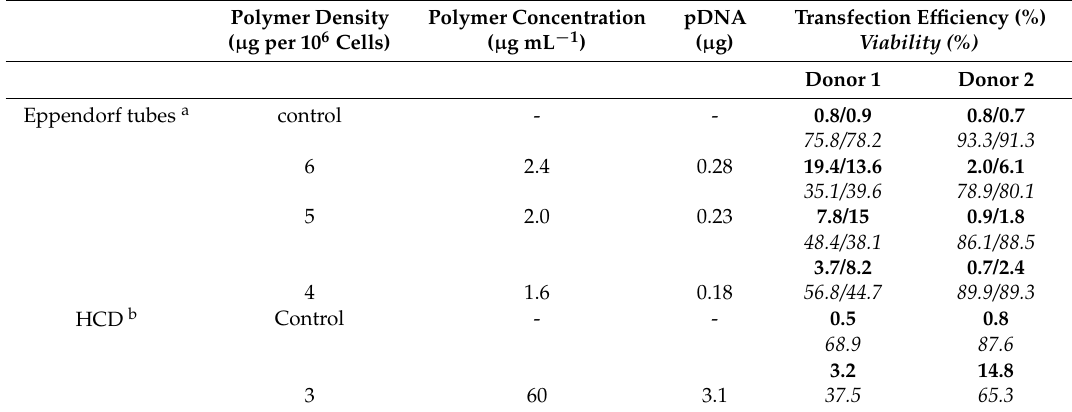
Table 6. Transfection in Eppendorf tubes and HCD transfection of human primary T